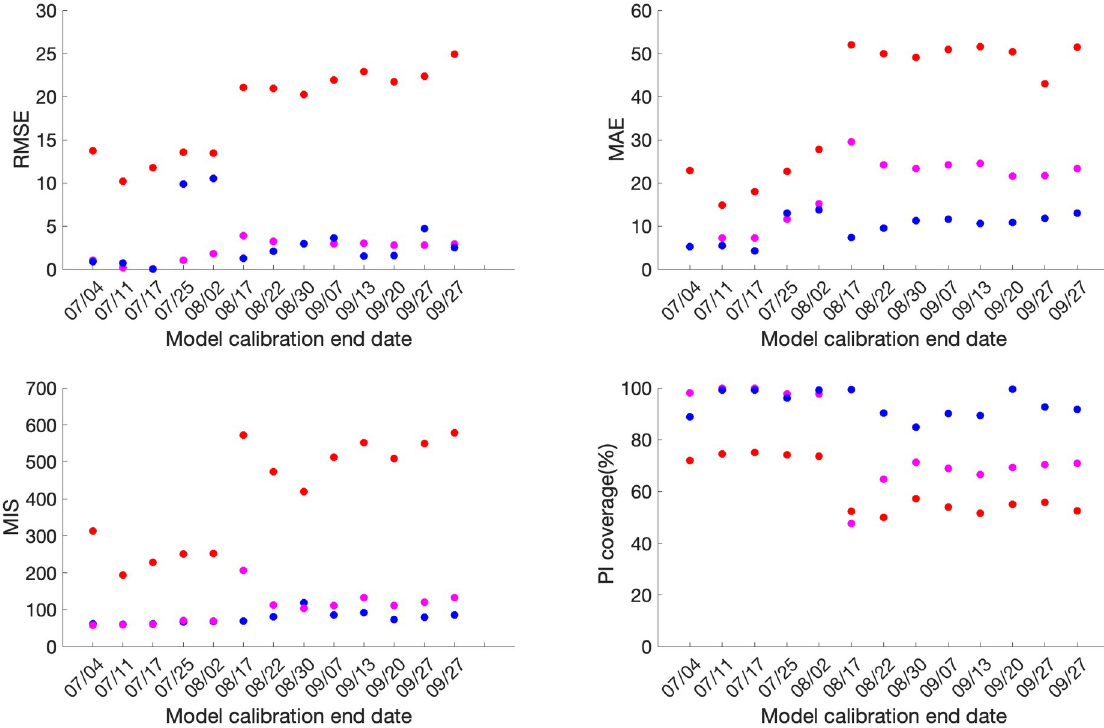
Fig 3. Calibration performance for each of the thirteen sequential calibration phases for GLM (magenta), Richards (red), and sub- epidemic (blue) model for Mexico City. High 95% PI coverage and lower mean interval score (MIS), root mean square error (RMSE) and mean absolute error (MAE) indicate better